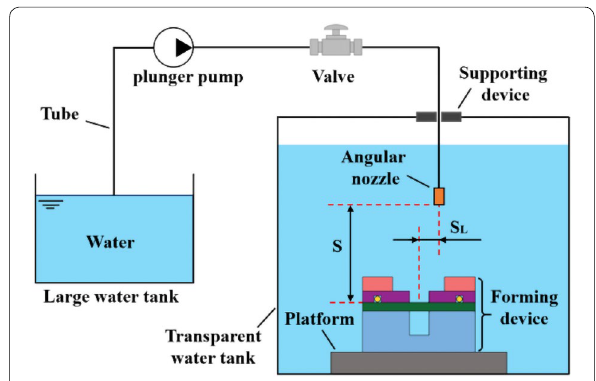
Figure 1 Experimental setup of water-jet cavitation shock microbulging process